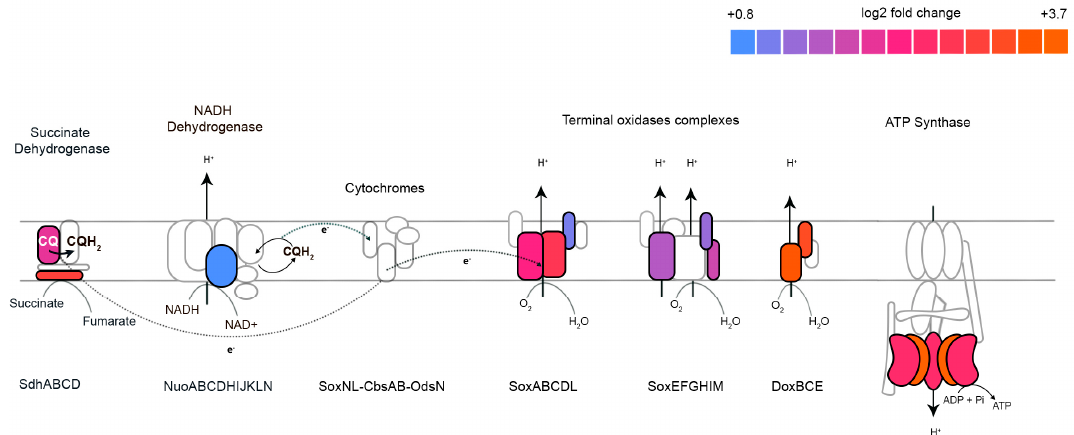
Figure 6. arCOG mapping of signi fi cantly a ff ected MW001 genes with terbina fi ne ( p -adjusted < 0.05): ( A ) Density plot illustrating log2 fold change distribution of genes, ( B ) Tally of genes mapping to the arCOG categories .